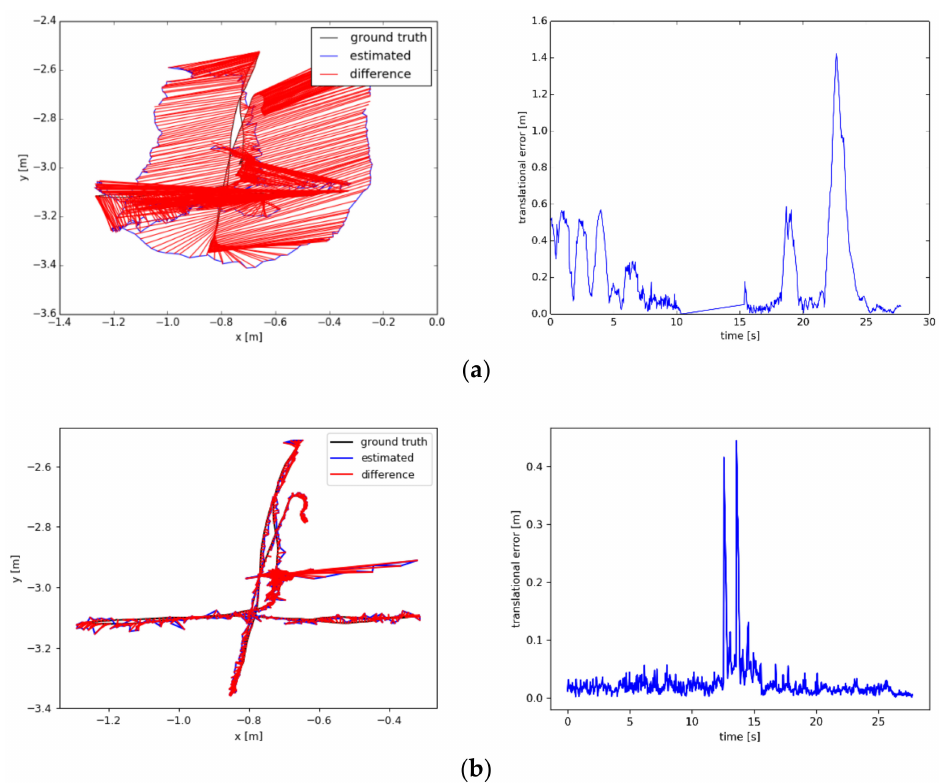
Figure 8. Visual experimental results: ( a ) ATE and RPE from ORB-SLAM2, ( b ) ATE and RPE from our